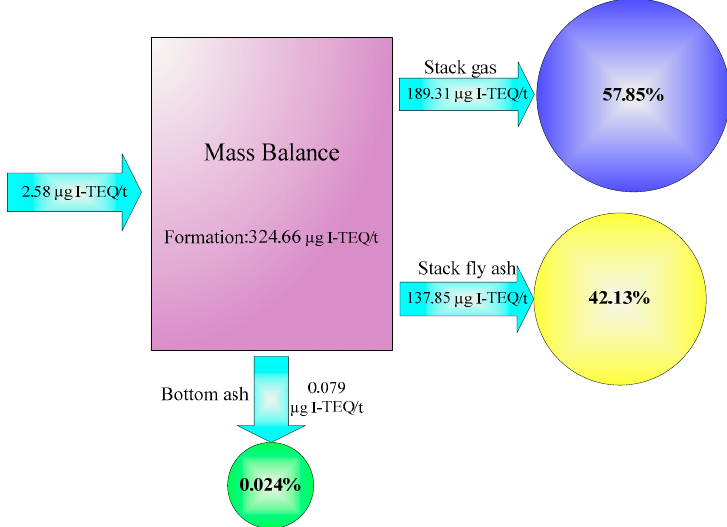
Figure 5. PCDD/F emission factor, distribution, and mass balance in the SWI. The percentage (%) is the proportion of individual output to total output.